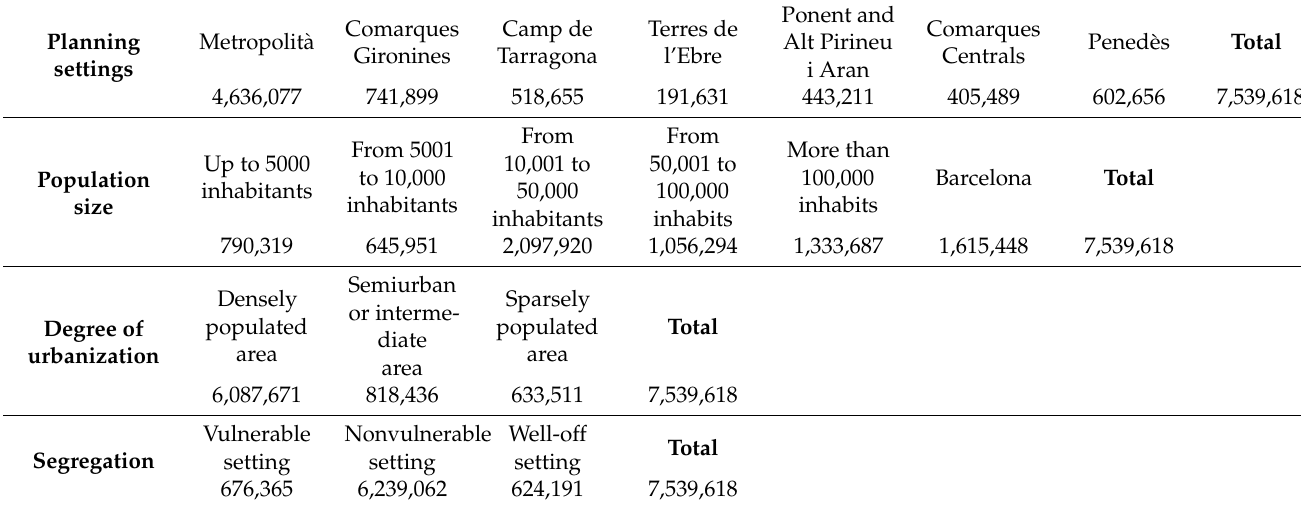
Table 1. Distribution of the population according to territorial aggregations. Catalonia, 2011.